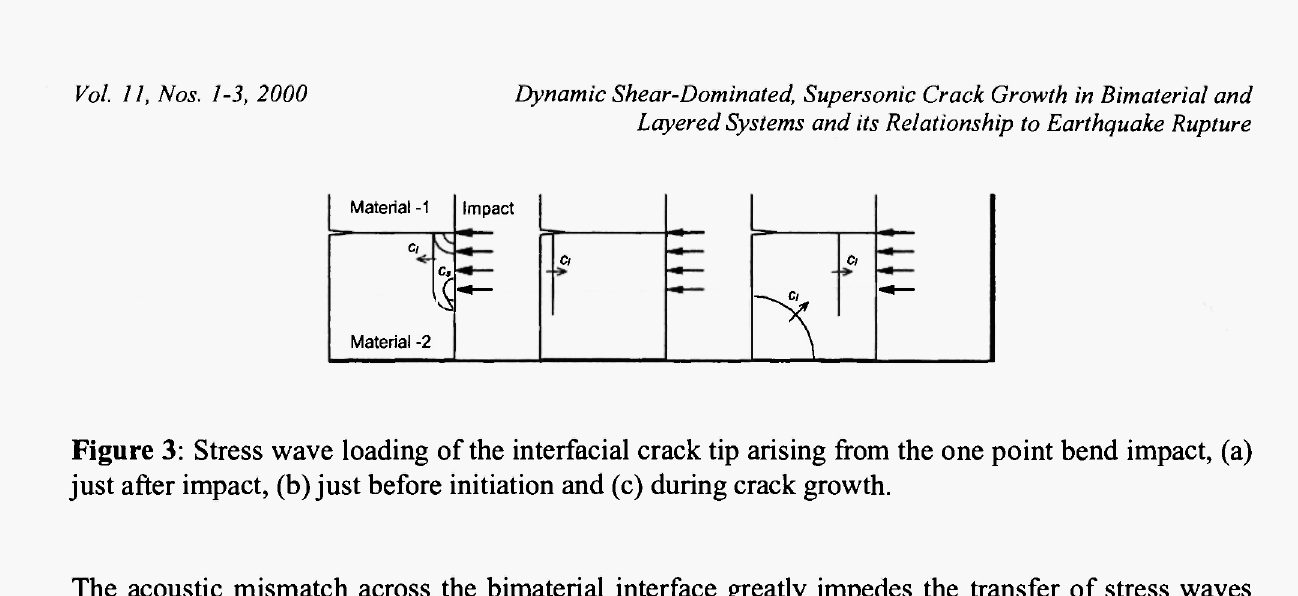
Figure 3: Stress wave loading of the interfacial crack tip arising from the one point bend impact, (a) just after impact, (b) just before initiation and (c) during crack